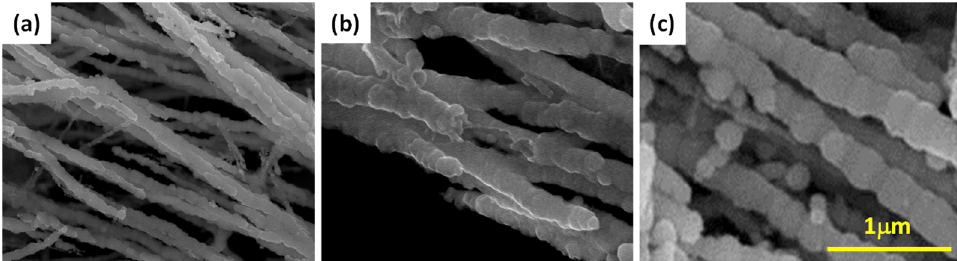
Figure 4. FE-SEM images of ( a ) Fe nanowires, ( b ) Fe@PANI-95/5, and ( c ) Fe@PANI-90/10.